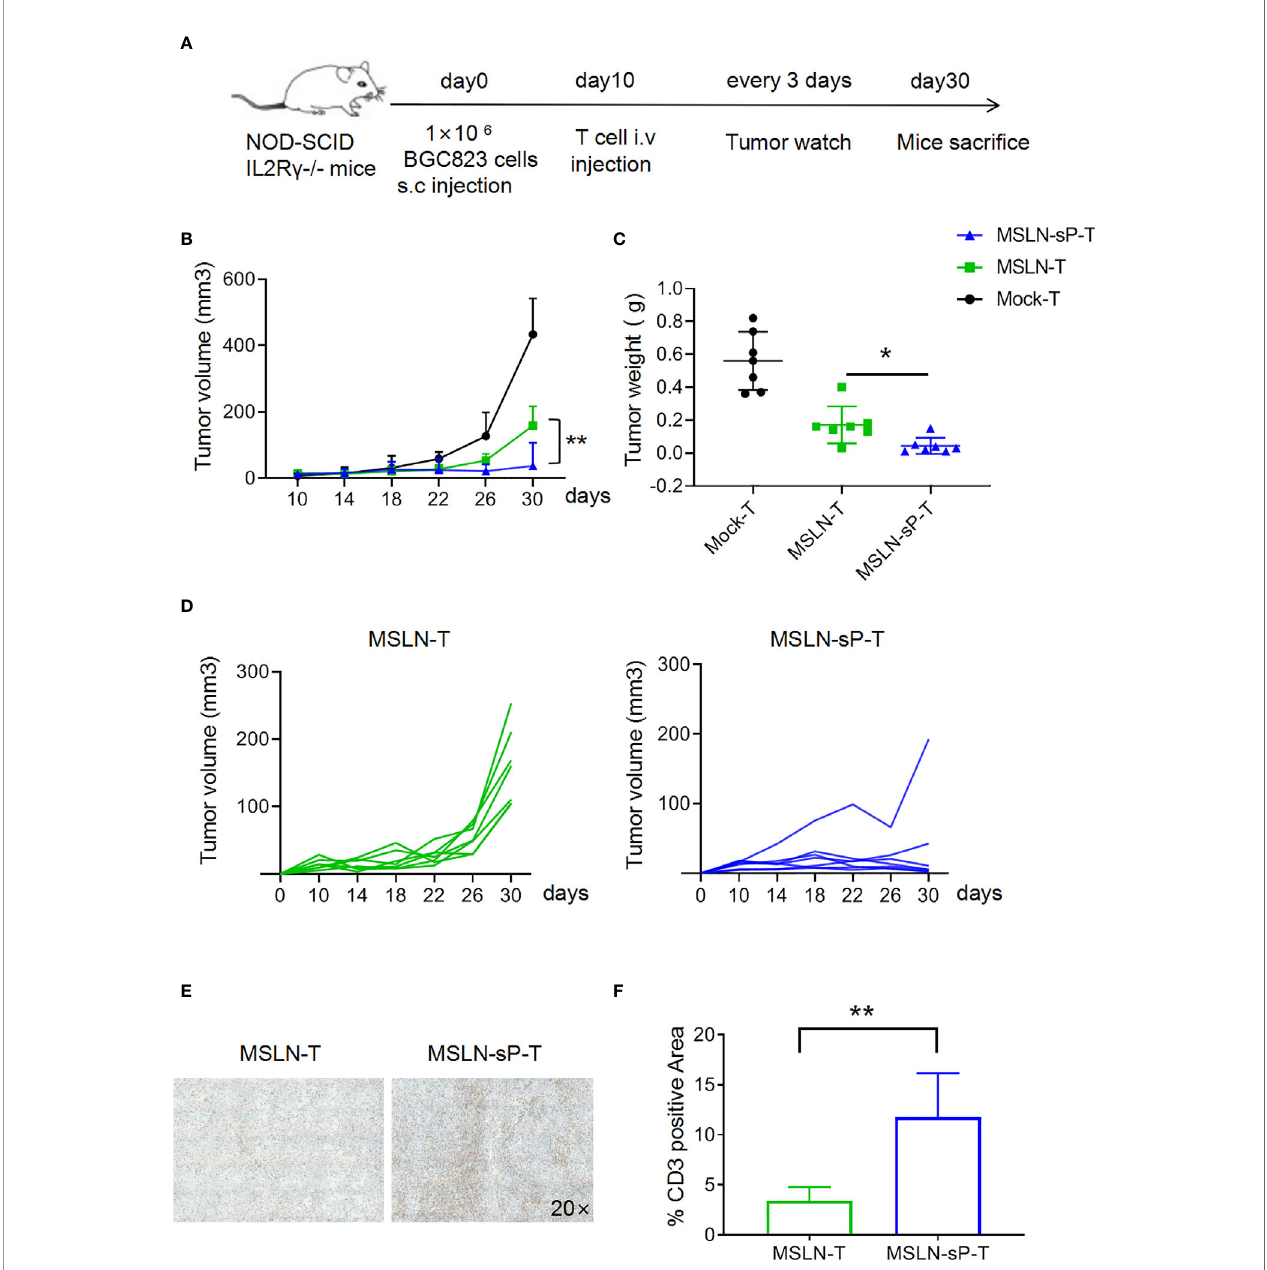
FIGURE 4 | sPH20-IgG2 enhances the in fi ltration and antitumor activity of anti-MSLN CAR-T cells in BGC823 gastric cancer mouse model. (A) Schematic diagram of the experiment,n=7 for each group. (B) Measurement of tumor volumes after treatment with Mock-T, anti-MSLN-T or anti-MSLN-sP-T cells; error bars denote the S. D, and the results were compared with two-way ANOVA. *P<0.05, **P<0.01. (C) Tumor weights of the Mock-T, anti-MSLN-T and anti-MSLN-sP-T cell groups on day 30 after tumor injection (time of sacri fi ce). (D) Tumor growth curves for the individual mice in the anti-MSLN-T and anti-MSLN-sP-T cell groups. (E) Representative images of IHC detection of tumor-in fi ltrated T cells in the anti-MSLN-T and anti-MSLN-sP-T cell groups. (F) Statistical analysis of tumor-in fi ltrated T cells in the anti-MSLN-T and anti-MSLN-sP-T cell groups. Error bars denote the S. D, and the results were compared with an unpaired t test. *P<0.05;